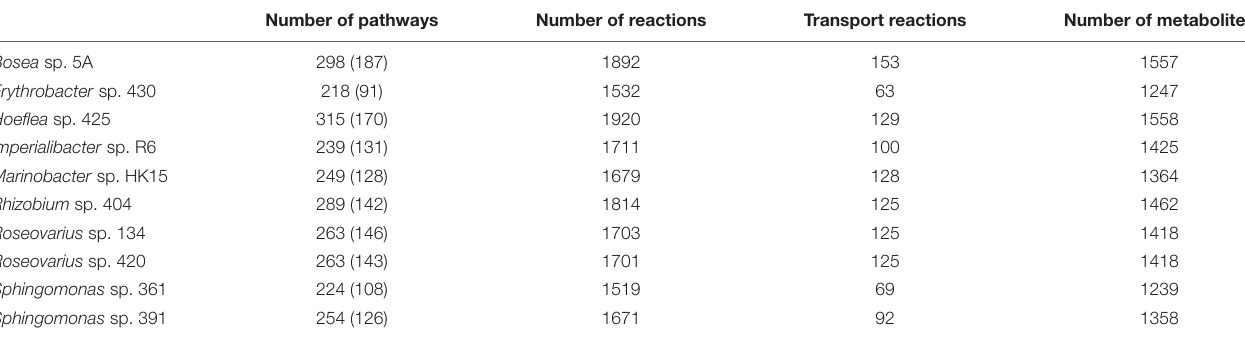
TABLE 2 | Number of predicted metabolic pathways (complete pathways in parentheses), reactions and metabolites in bacterial metabolic networks. Number of pathways